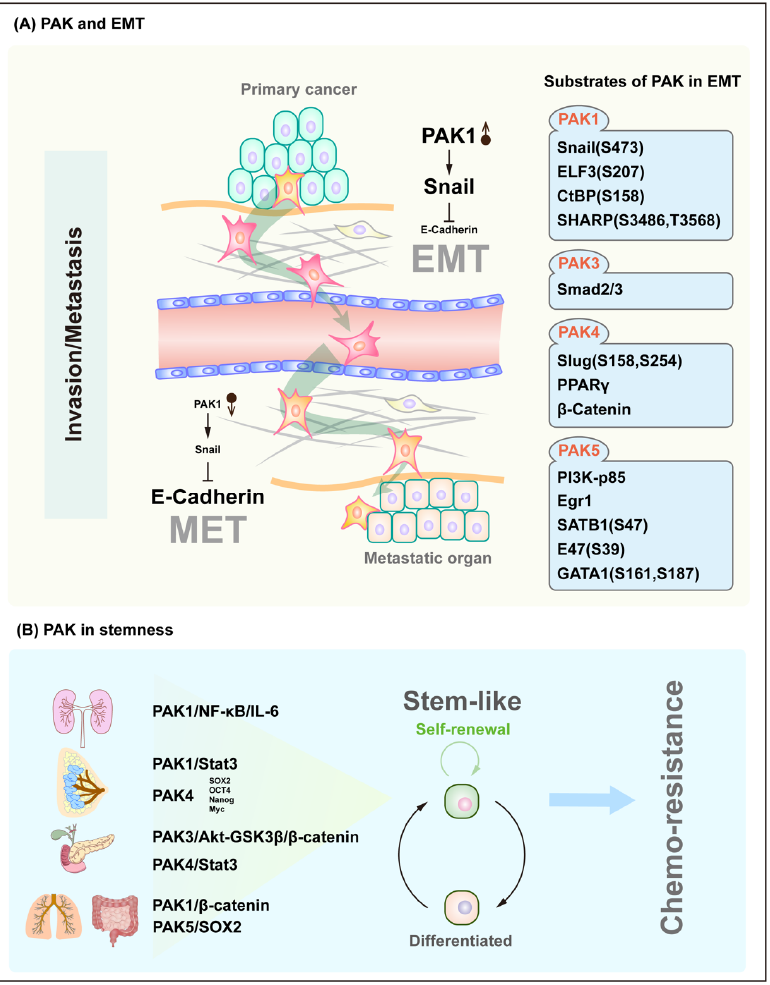
Figure 5. PAK signaling in plasticity. ( A ) PAK and EMT. All of the PAK downstream proteins that are involved in EMT are listed in the corresponding boxes, and each following brackets indicate the sites of PAK phosphorylation. Overexpression of PAK leads to EMT, followed by invasion and metastasis, and after reaching the metastatic organ, PAK expression is decreased, and MET occurs. ( B ) PAK and stemness. The signaling pathway of PAK in the corresponding organ leads to a stem cell